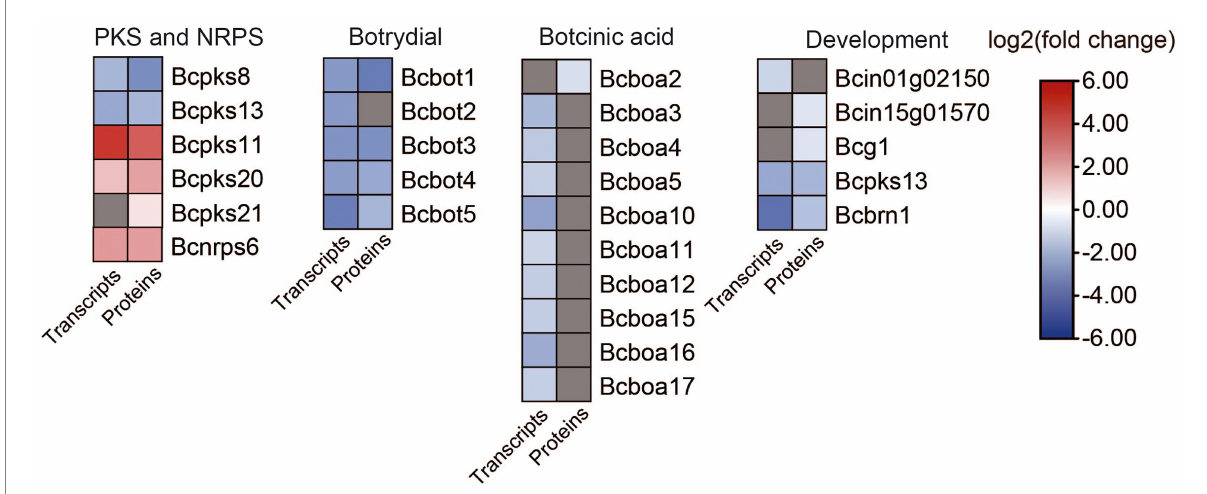
FIGURE 7 Heat map of DEGs and DEPs in secondary metabolism key enzymes encoding genes and development between the B. cinerea TB-31 and Δ Bcfrp1. The heat map was generated with the software TBtools (Toolbox for Biologists) V1.0971. The gray color means no significant difference at the transcription or translation level.